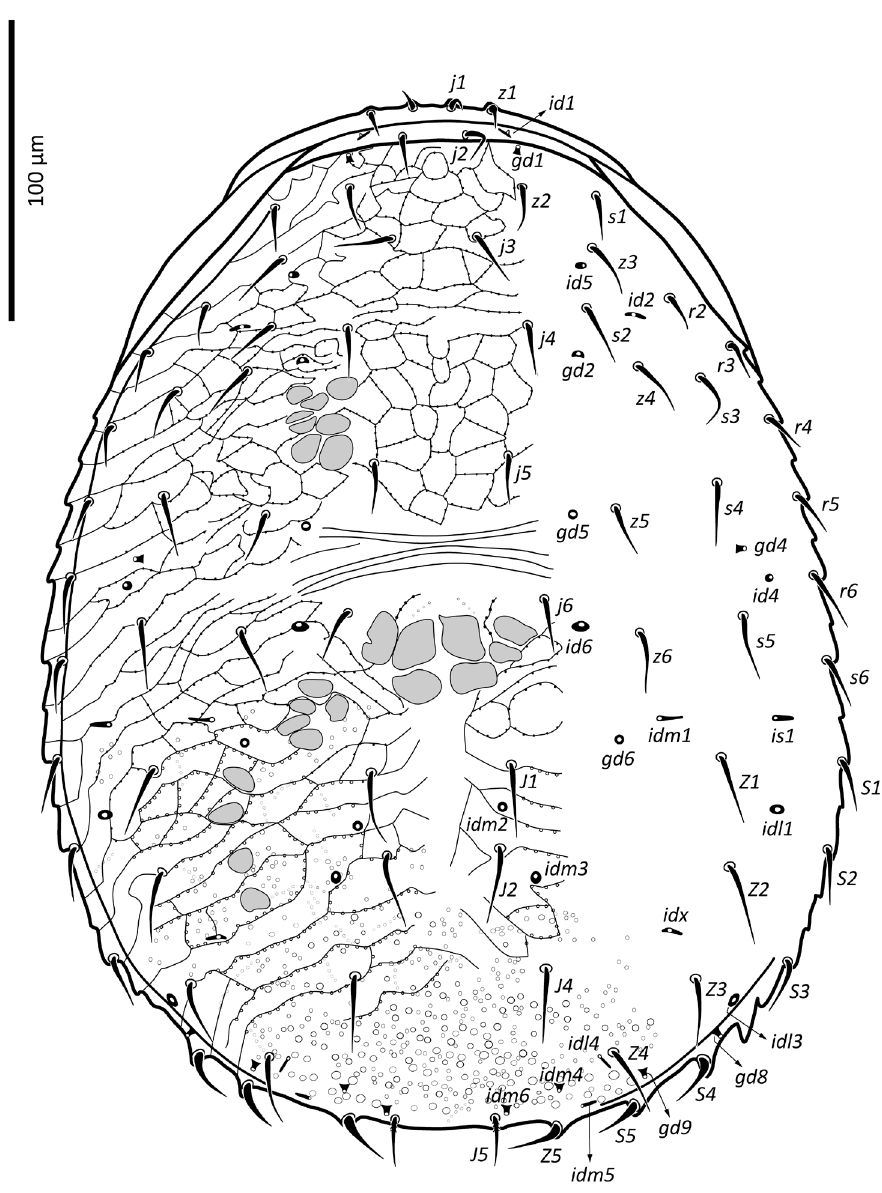
Figure 1. Zygoseius papaver sp. n., female, dorsal idiosoma.